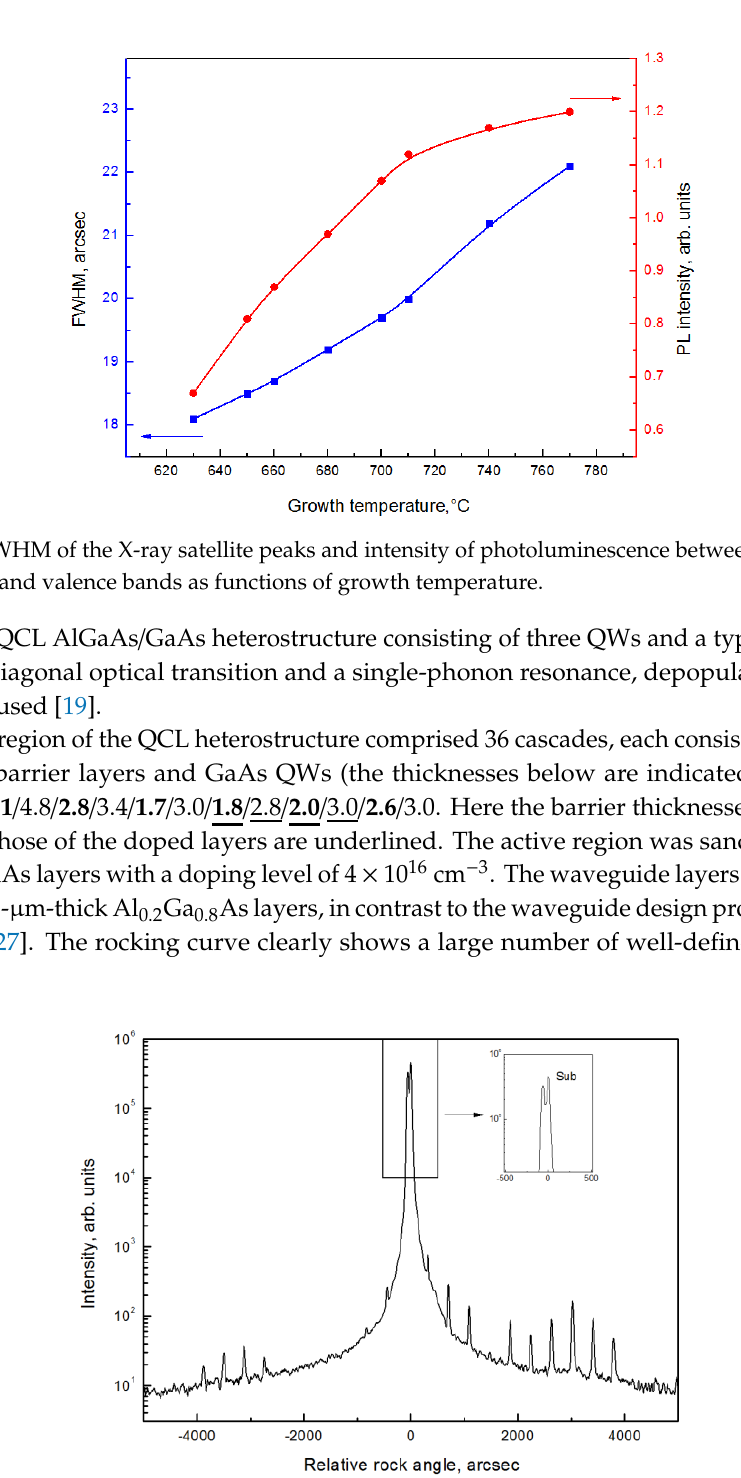
Figure 3. Rocking curve of a superlattice consisting of 250 pairs of Al 0.45 Ga 0.55 As (2.3 nm)/GaAs (3.7 nm) layers.